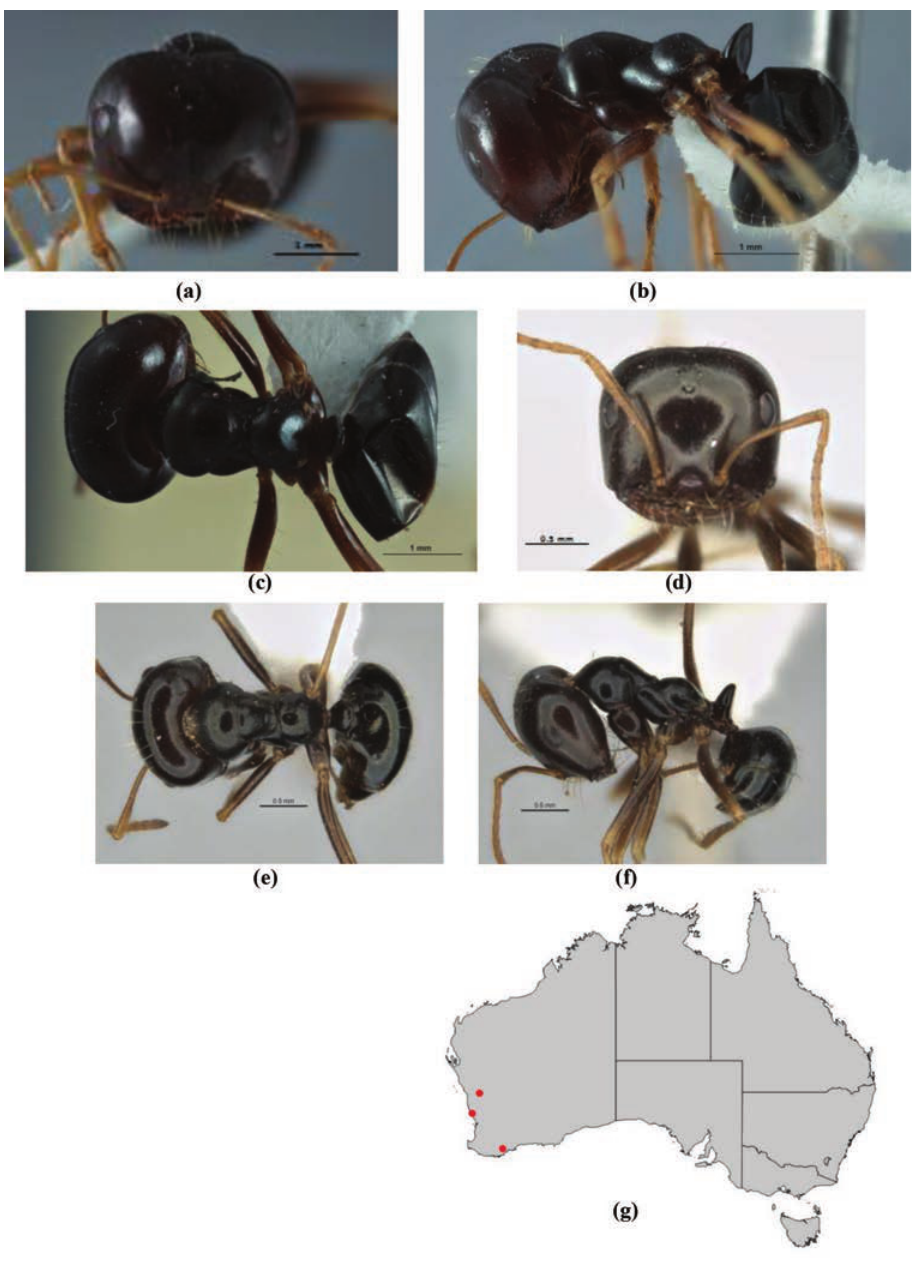
Figure 86. Melophorus purpureus sp. n.: major worker paratype (JDM32-001885–top ant) frons ( a ), profile ( b ) and dorsum ( c ); minor worker holotype (JDM32-001885–middle ant) frons ( d ), profile ( e ) and dorsum ( f ); distribution map for the species ( g ). Low resolution scale bars: 1 mm ( a–c ); 0.5 mm ( d–f